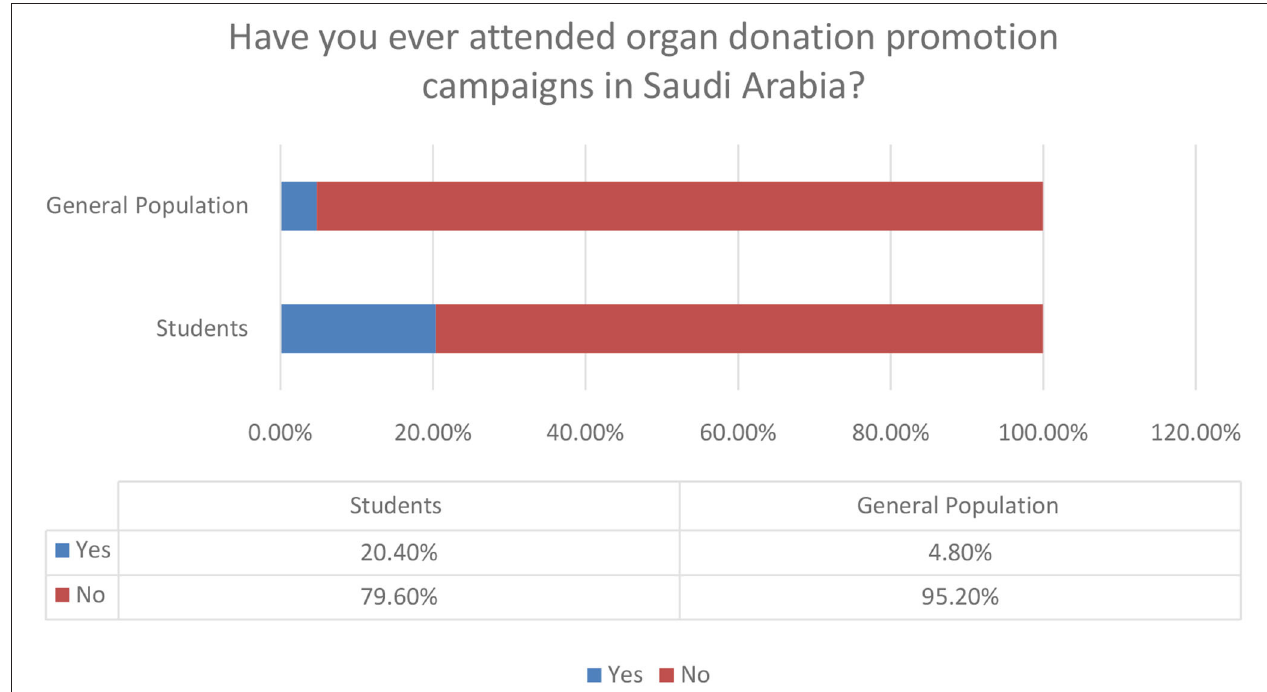
FIGURE 9 | Personal attendance in organ donation promotion campaigns.